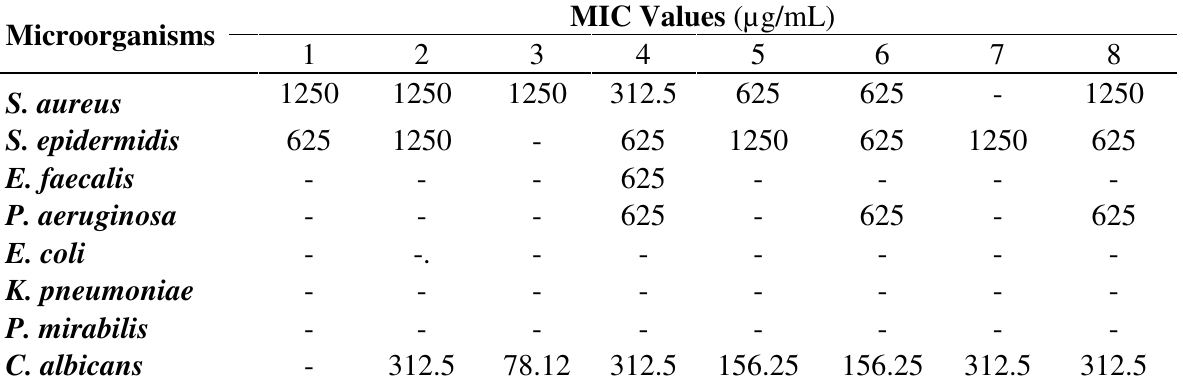
Table 2. In vitro antibacterial and antifungal activity of 1,3-Dioxolane derivatives.